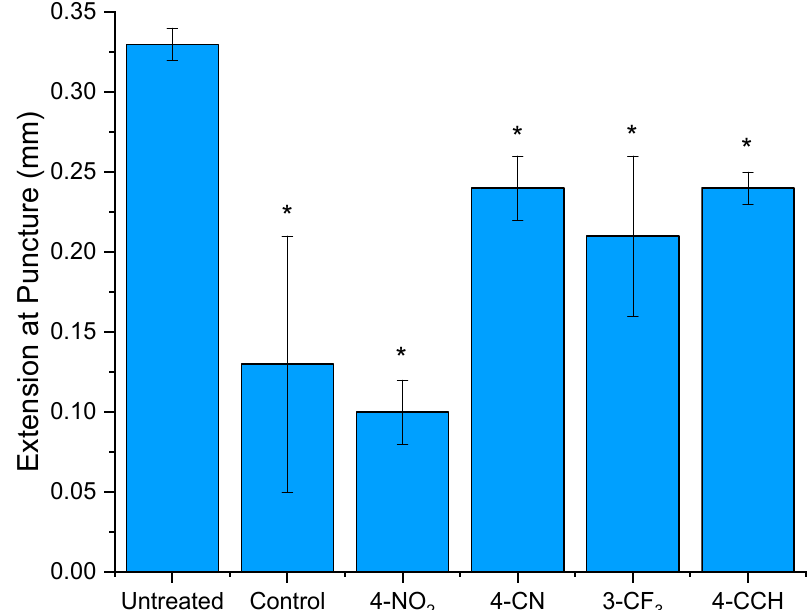
Figure 6. Extension at puncture for all treated samples, including untreated and control samples. Errors are standard deviation, * denotes statistically significant difference to untreated sample, P < 0.05.